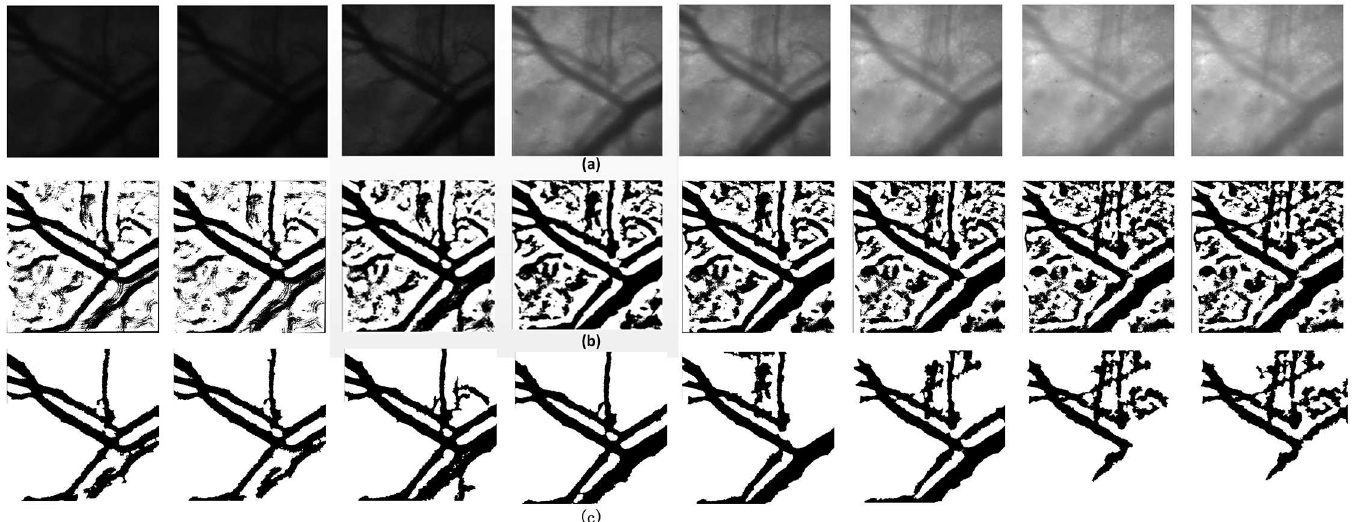
Fig 3. (a) singleband images of hyperspectral vessel image, (b) binary images after fast thresholdtarget extracting process, (c) target vessel after counter filtering process.